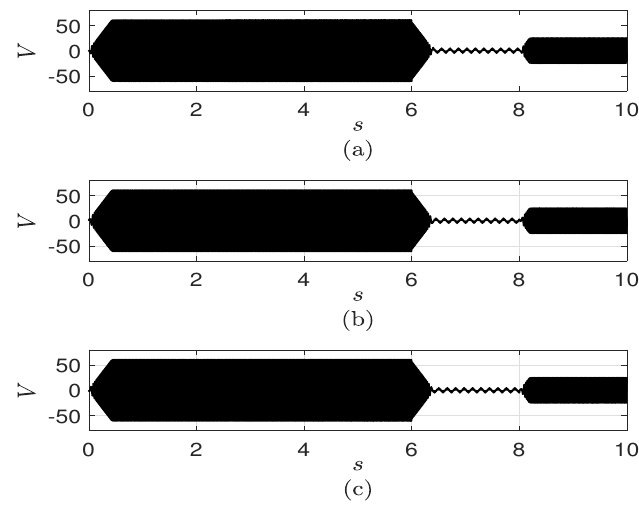
Figure 13. ( a ) Control voltage u a ; ( b ) Control voltage u b ; ( c ) Control voltage u c .